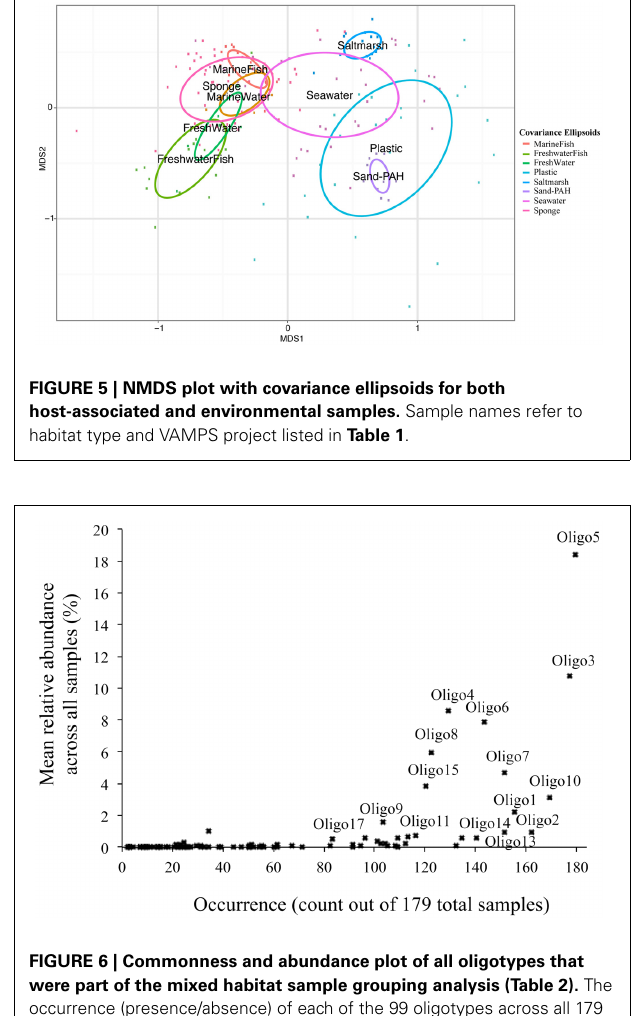
samples were collected as compared to Sand-PAH and Saltmarsh samples. All other pairwise comparisons were insignificant at the 0.05 alpha level after multiple comparison